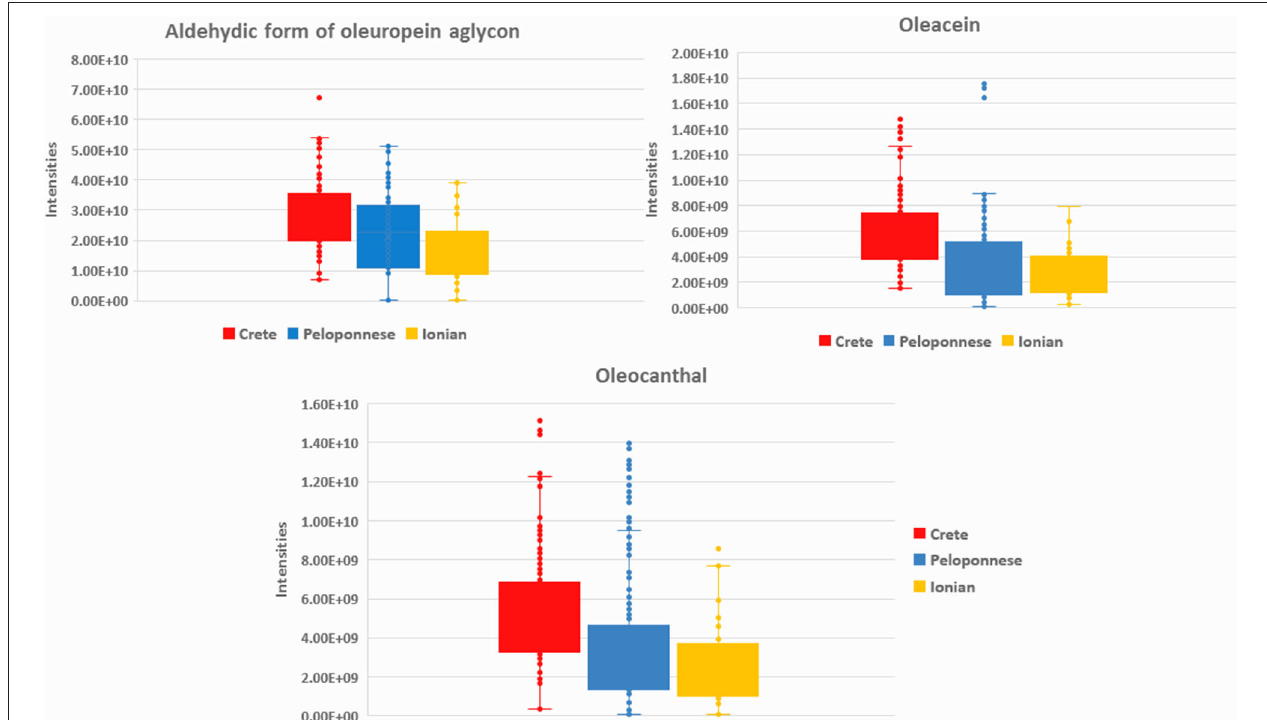
FIGURE 3 | Box-plots of aldehydic form of oleuropein aglycon ( 44 ), oleacein ( 38 ), and oleocanthal ( 32 ) in the three basic geographical regions Crete (red), Peloponnese (blue), and Ionian islands (yellow).